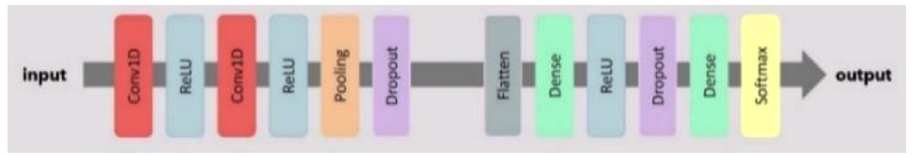
Figure 2. 1-D Convolution Neural Network. The illustration above shows the various layers used to develop the machine learning model. The various layers include Conv1D layers, Rectified Linear Unit (ReLU) Activation function, Pooling layers, Dropout, and Dense